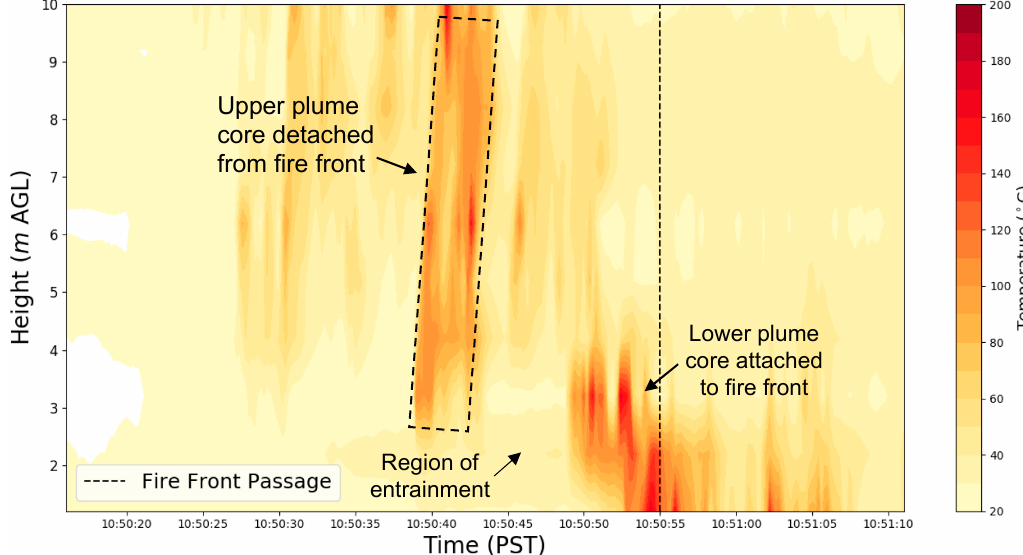
Figure 14. Time–height plot of 5-Hz thermocouple temperatures on the interior 12-m tower showing plume core thermal structures and separation caused by strong entrainment that develops two coherent and isolated plume cores. The plume impacted the tower from approximately 10:50:27 to 10:51:10 PDT. This is also shown in the photographic time series of Figure 8. Vertical dashed line indicates FFP.